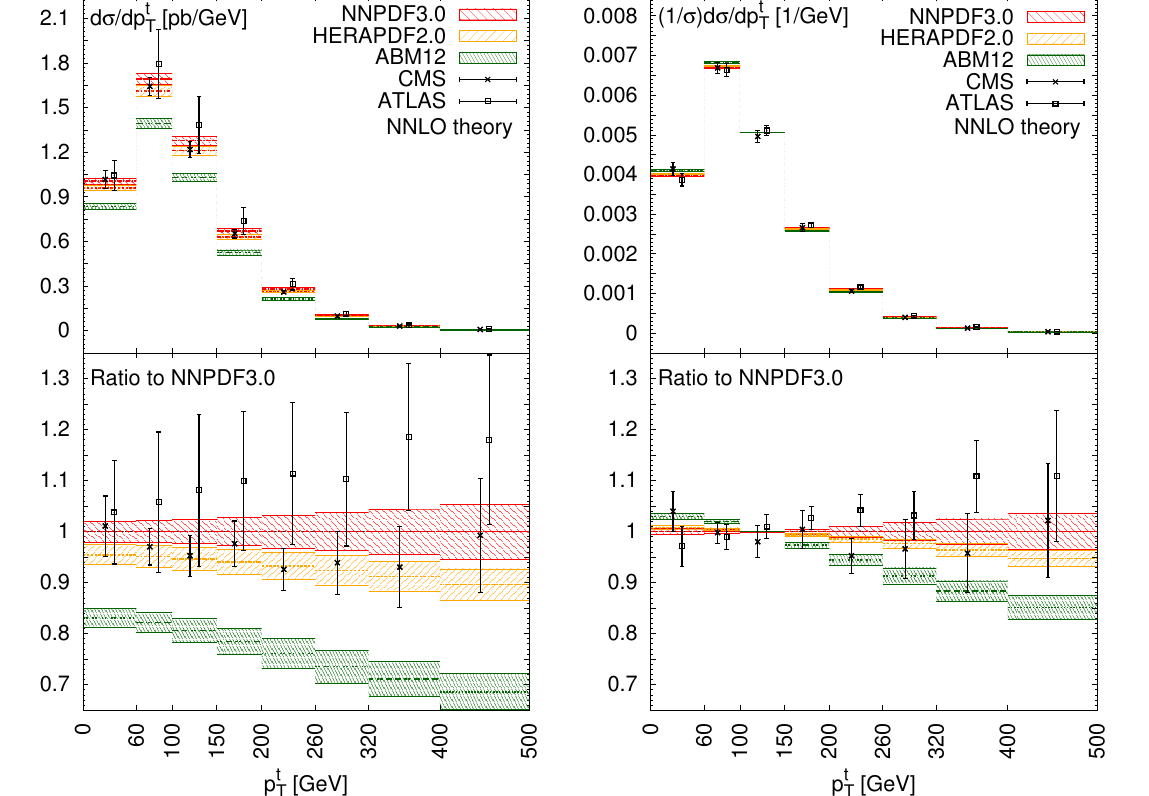
Figure 6 . Same as (cid:12)gure 5 for the HERAPDF2.0 and ABM12 PDF